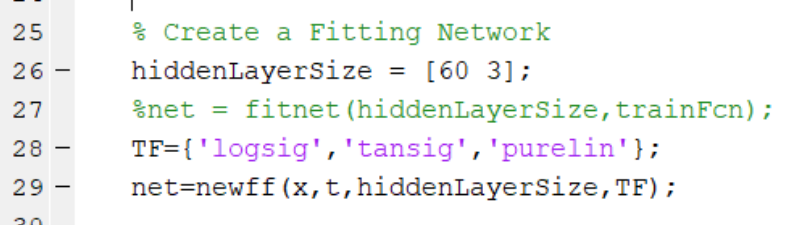
Figure 9. Different activation functions.